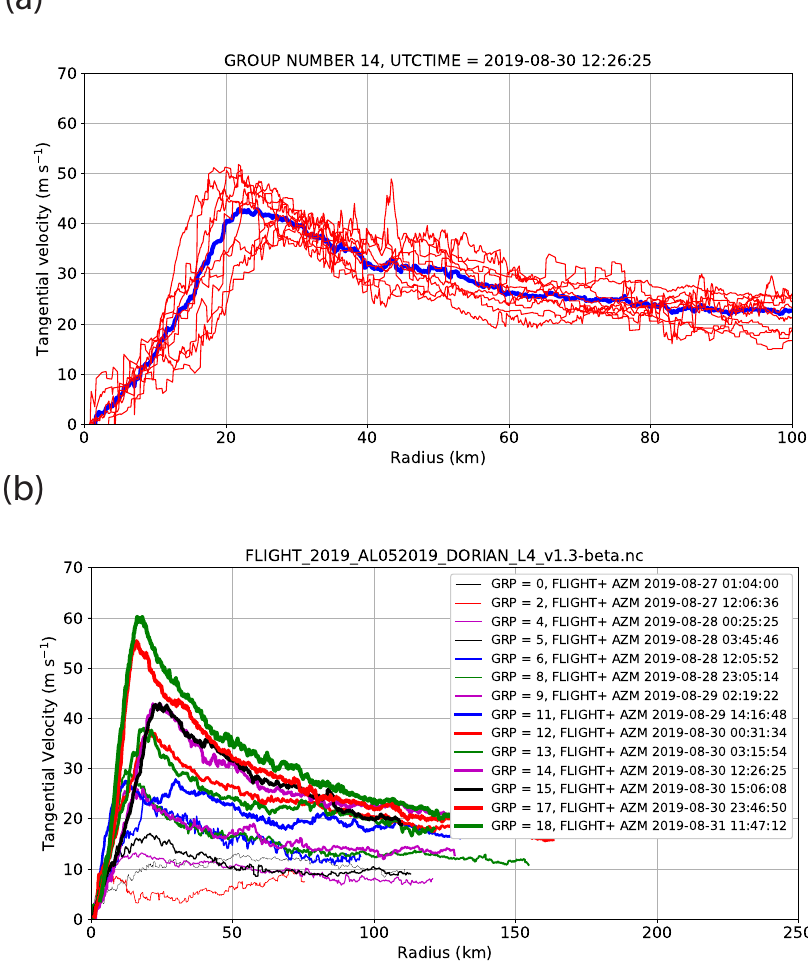
Figure 5. Panels: ( a ) Azimuthal mean FL tangential velocity for Hurricane Dorian (2019) azimuthal mean group 14 (valid 1226 UTC 30 August 2019) (blue) and radial legs contributing to the azimuthal mean (red), and ( b ) Azimuthal mean FL tangential velocity for first 14 valid azimuthal mean groups of Hurricane Dorian